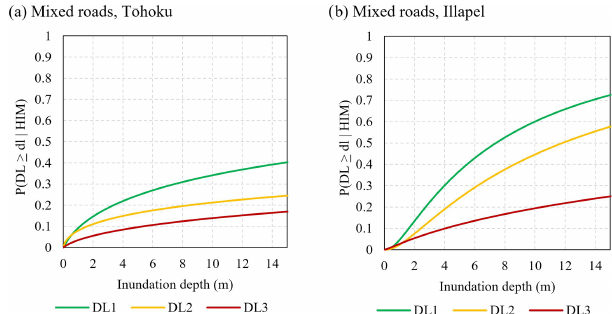
Figure 13. Fragility functions for mixed-construction roads (a) for the 2011 T ¯ ohoku earthquake and tsunami, Japan, and for mixed- construction roads (b) for the 2015 Illapel earthquake and tsunami, Chile.